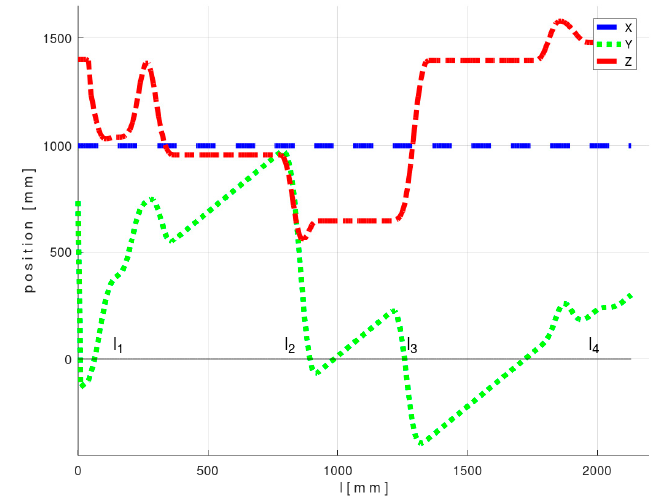
Figure 19. Test 1—Diagram of the optimal course of the TCP OPT during the passage of the frame through the fiber-processing head-values of the first three parameters of optimal TCP OPT